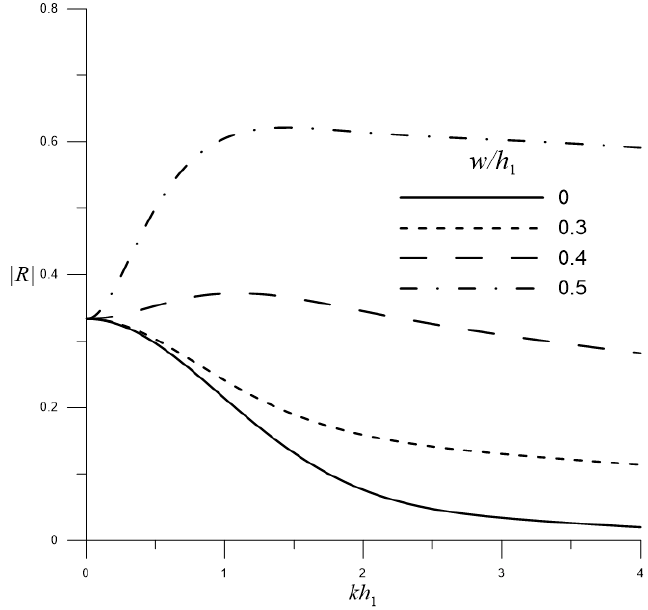
Figure 11. Reflection coefficient | R | varying against kh 1 for a single bottom-standing barrier at different locations.